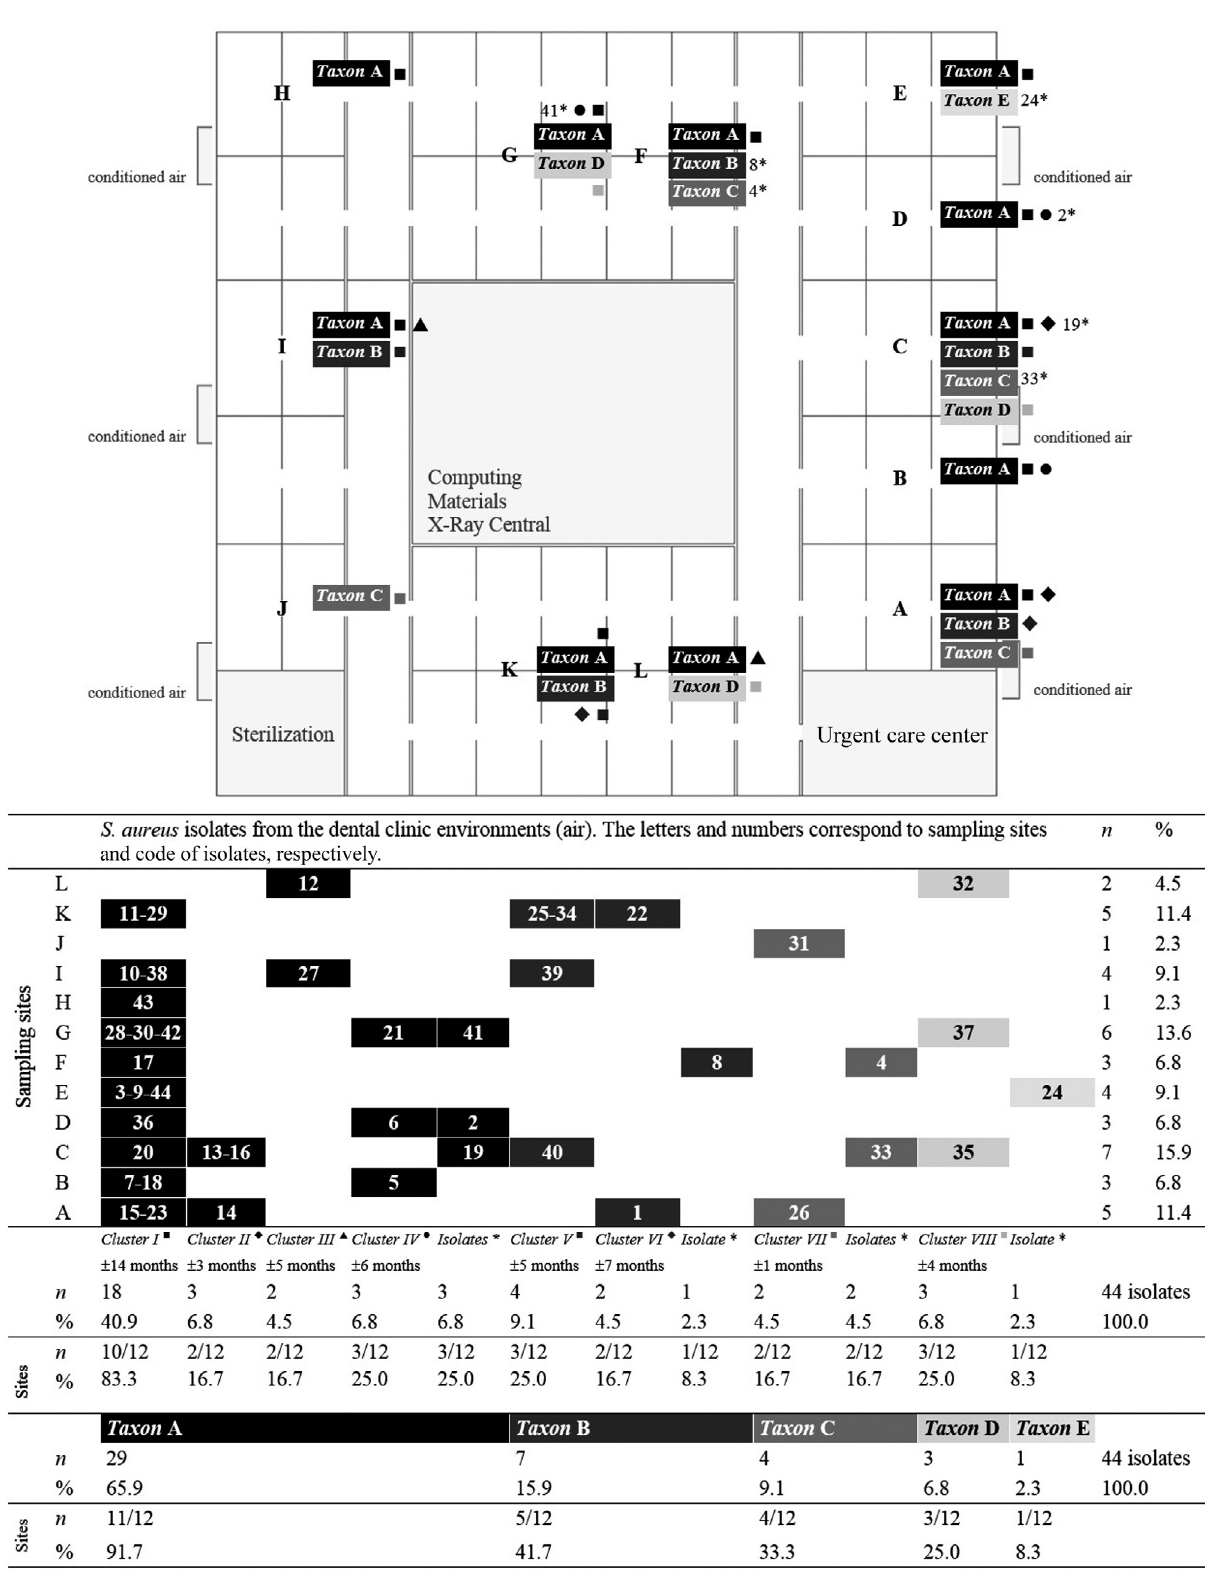
Figure 5- Design of the Academic Dental Clinic (School of Dentistry at Piracicaba, State University of Campinas, Brazil). The letters A to L are the sampling sites (Cluster I ■, Cluster II ♦, Cluster III ▲, Cluster IV ●, Cluster V ■, Cluster VI ♦, Cluster VII ■, Cluster VIII ■ and isolates